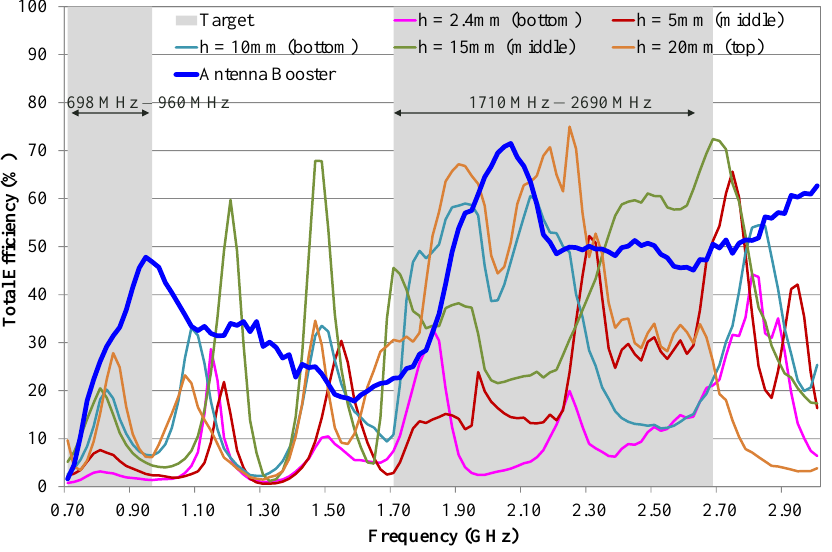
Figure 10. Measured total efficiencies for the antenna booster and the FPC antenna. The best efficiency among the three positions (top, middle, and bottom) is shown for the FPC antenna at a given height. Table 4. Measured total efficiency for the FPC antenna and antenna booster.